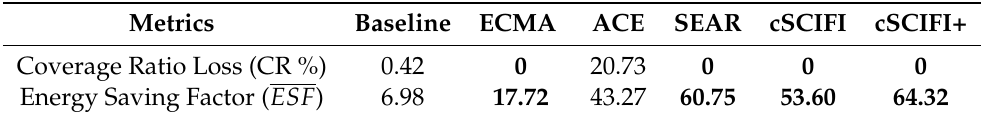
Table 4. Mechanism’s best results